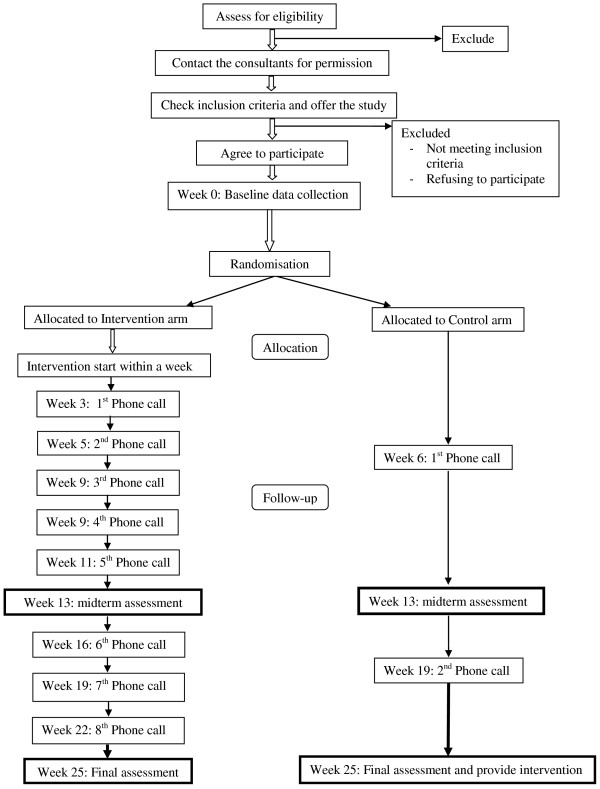
Study Design in flow diagram. Recruitment, randomisation, follow-up and outcomes assessment.